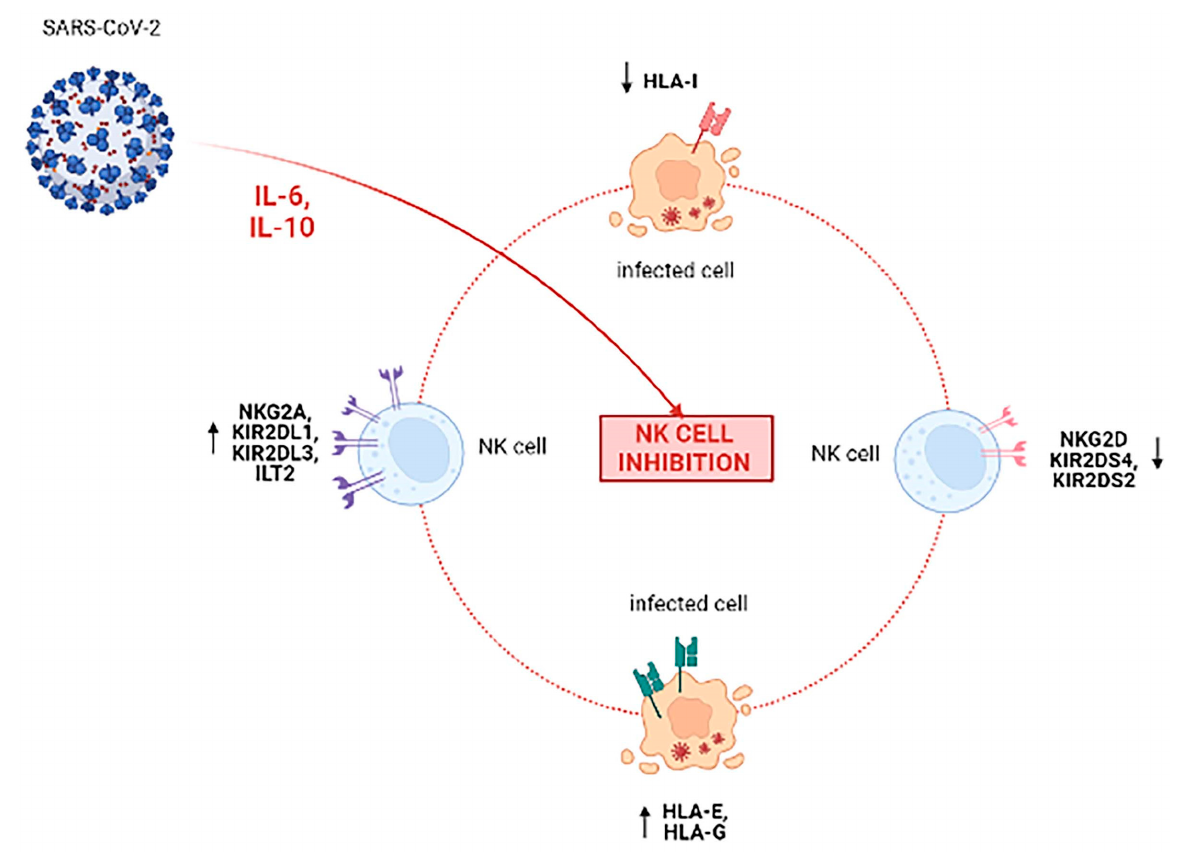
Figure 6. Impairment of NK cells’ functions during SARS-CoV-2 infection. The release of cytokines such as interleukin (IL)-6 and IL-10 affects NK cell activation through changes in NK receptor and HLA molecules expression.